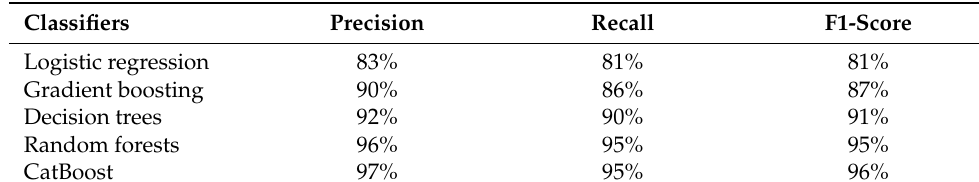
Table 2. Results of metrics to evaluate each classifier model.